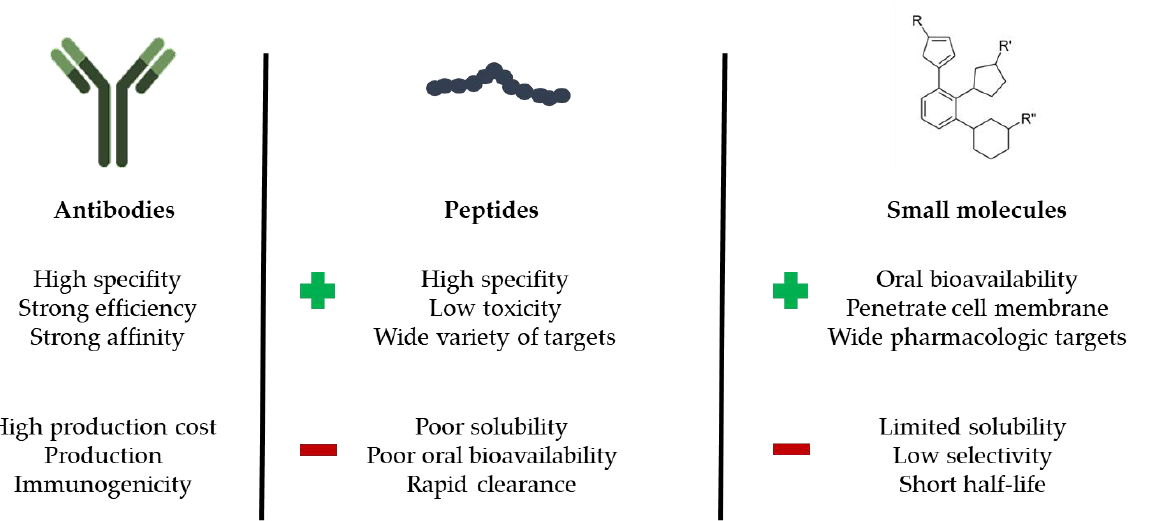
Figure 1. Comparison between antibodies, peptides and small molecules with main advantages and disadvantages as PPI modulators.